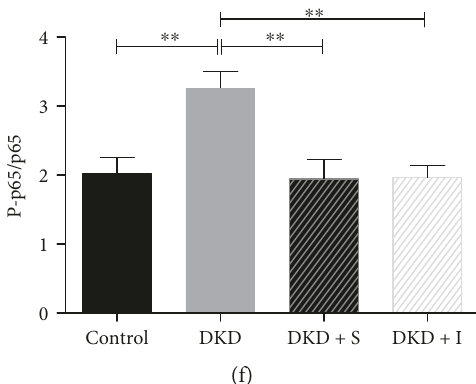
Figure 3: SYFSF serum inhibited renal in fl ammation in DKD rats. (a) Immunohistochemical staining of MCP-1, TNF- α , and NF- κ Bp65 is shown. (b, c) The expression of MCP-1, TNF- α , and NF- κ Bp65 was scored. SYFSF inhibited the expression of MCP-1 and TNF- α . (d) There was no signi fi cant di ff erence in NF- κ Bp65 expression. (e, f) The expression of phosphorylated NF- κ Bp65 was obviously increased in the DKD group in western blot. SYFSF and irbesartan had almost similar e ff ects on the inhibition of NF- κ Bp65 phosphorylation. DKD +S represents the DKD rats treated with SYFSF. DKD+ I represents the DKD rats treated with irbesartan. ∗ P < 0 05 , ∗∗ P < 0 01 , and ∗∗∗ P < 0 001